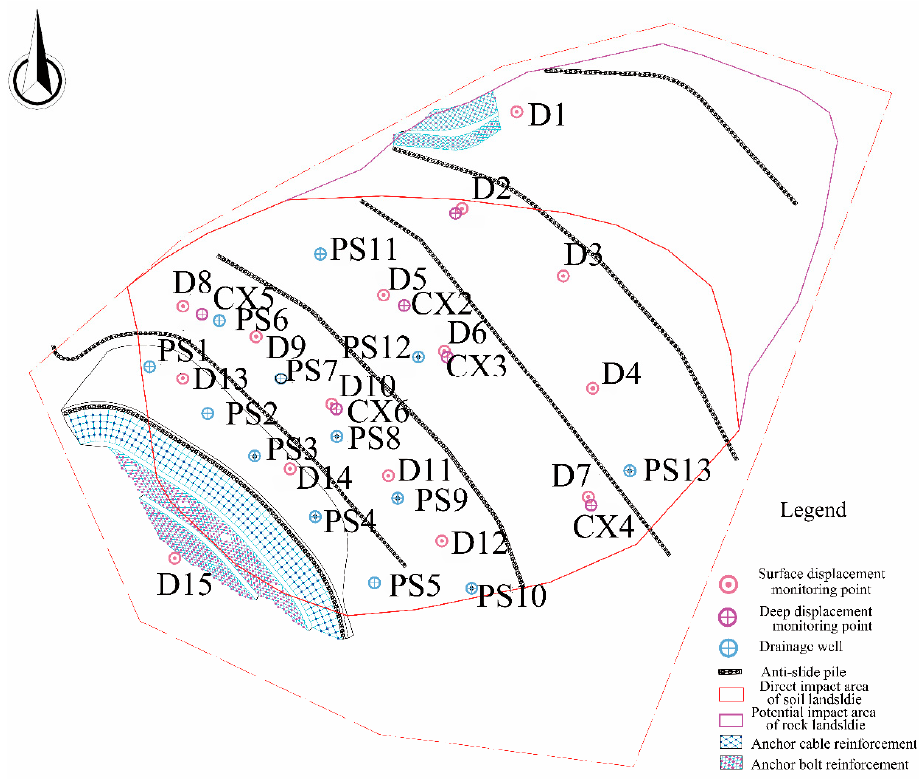
Figure 6. Treatment of the Fangshan landslide and location of monitoring points.